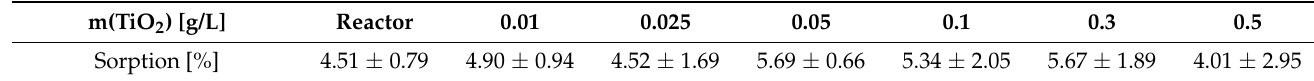
Table 1. Adsorption behavior of bisphenol A to the reactor and various dosages of TiO 2 nanoparticles (Degussa P25) under dark conditions after 1 h with time steps of 15